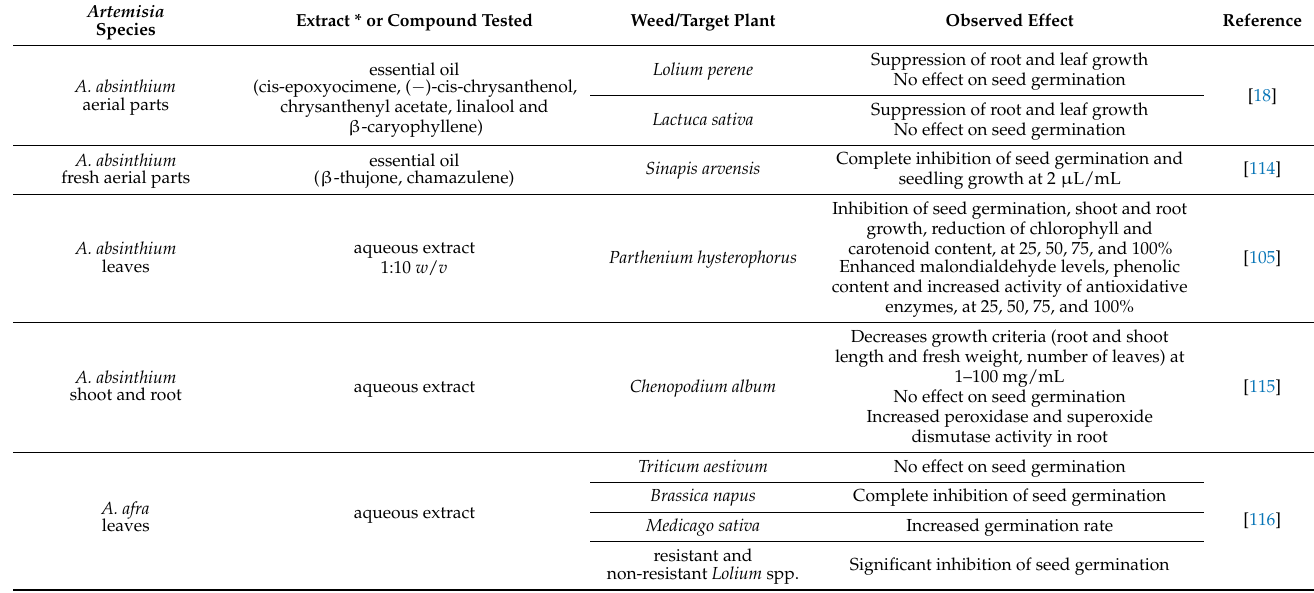
Table 3. Phytotoxic activity of Artemisia compounds and